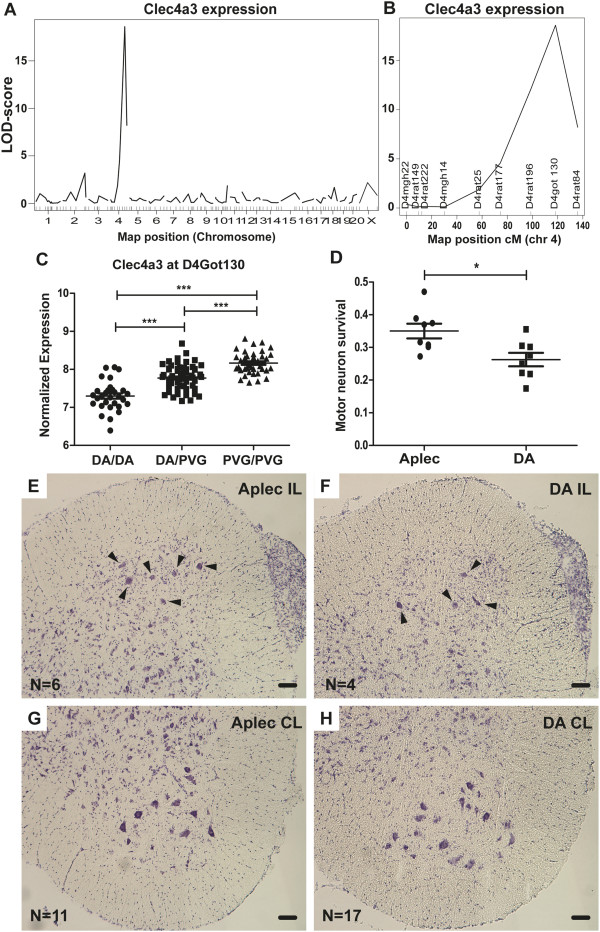
Clec4a3 is cis-regulated after nerve root injury and the Aplec complex confers neuroprotection. The inbred DA and PVG rat strains display considerable, genetically determined, differences in spinal cord motor neuron survival following VRA. Global expressional profiling of lesioned spinal cord ventral horn tissue from an F2 (DAxPVG) intercross reveals several strong eQTLs. One of the strongest eQTLs among more than 27,000 transcripts is Clec4a3, a C-type lectin with hitherto unknown function in the CNS. Clec4a3 was cis-regulated from chromosome 4 (A) from marker D4Got130 (B). All F2 animals were genotyped over the whole genome and the PVG genotype in marker D4Got130 was found to lead to higher expression of Clec4a3 (C), with highest expression in PVG homozygotes; the heterozygotes displayed an intermediate phenotype. The Aplec congenic strain, which has a small fragment from PVG onto DA background containing six characterized C-type lectin genes including Clec4a3, displays significantly improved motor neuron survival compared to DA at 21 days after VRA (D). A representative section from the L4 segment shows motor neurons in the ventral horn on the contralateral (CL) and ipsilateral (IL) sides of the cord (axotomized cells are indicated by arrows) in one Aplec (E and G) and one DA (F and H) rat. In A the x-axis marks each chromosome and in B it is the genetic distance on chromosome 4 measured in centimorgans (cM); the y-axis shows the logarithm of odds (LOD)-score, where LOD > 3.1 corresponds to a genome wide P < 0.001, and the current LOD-score of around 20 to P = 0. The scale bar in the micrographs corresponds to 80 μm. Aplec: antigen-presenting lectin-like receptor gene complex; CL: contralateral; CNS: central nervous system; eQTL: expression quantitative trait loci; IL: ipsilateral; LOD: logarithm of odds; VRA: ventral root avulsion.